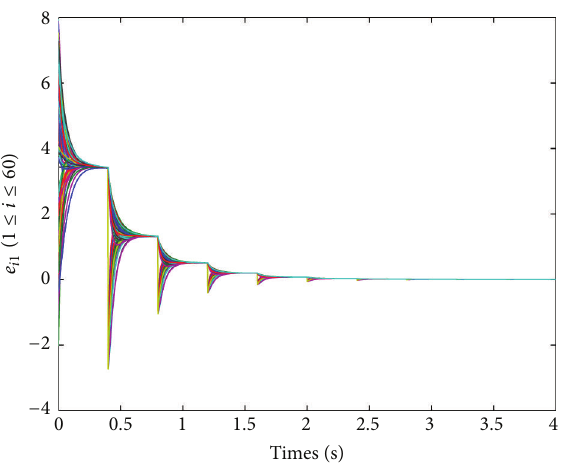
Figure 5: Rhythmic errors 𝑒 𝑖1 in BA network.